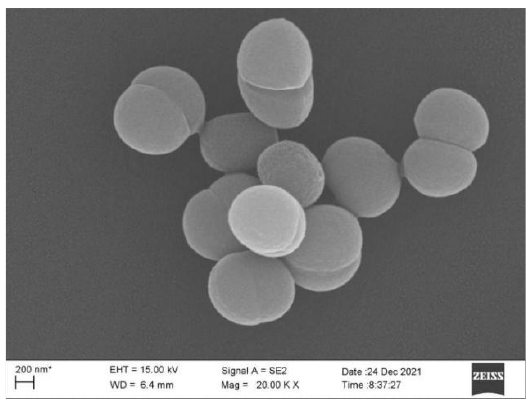
Figure 1. Scanning electron micrographs of cells of Planococcus XW-1.